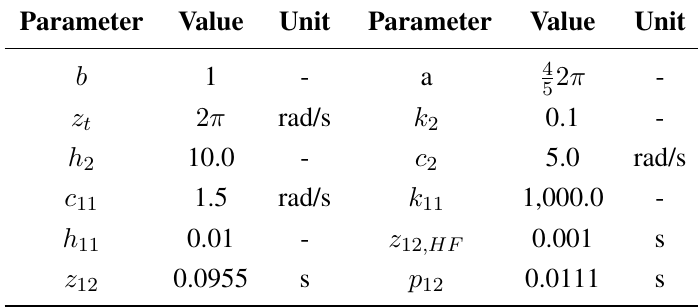
Table A3. Controller weightings and parameters for the robust design.